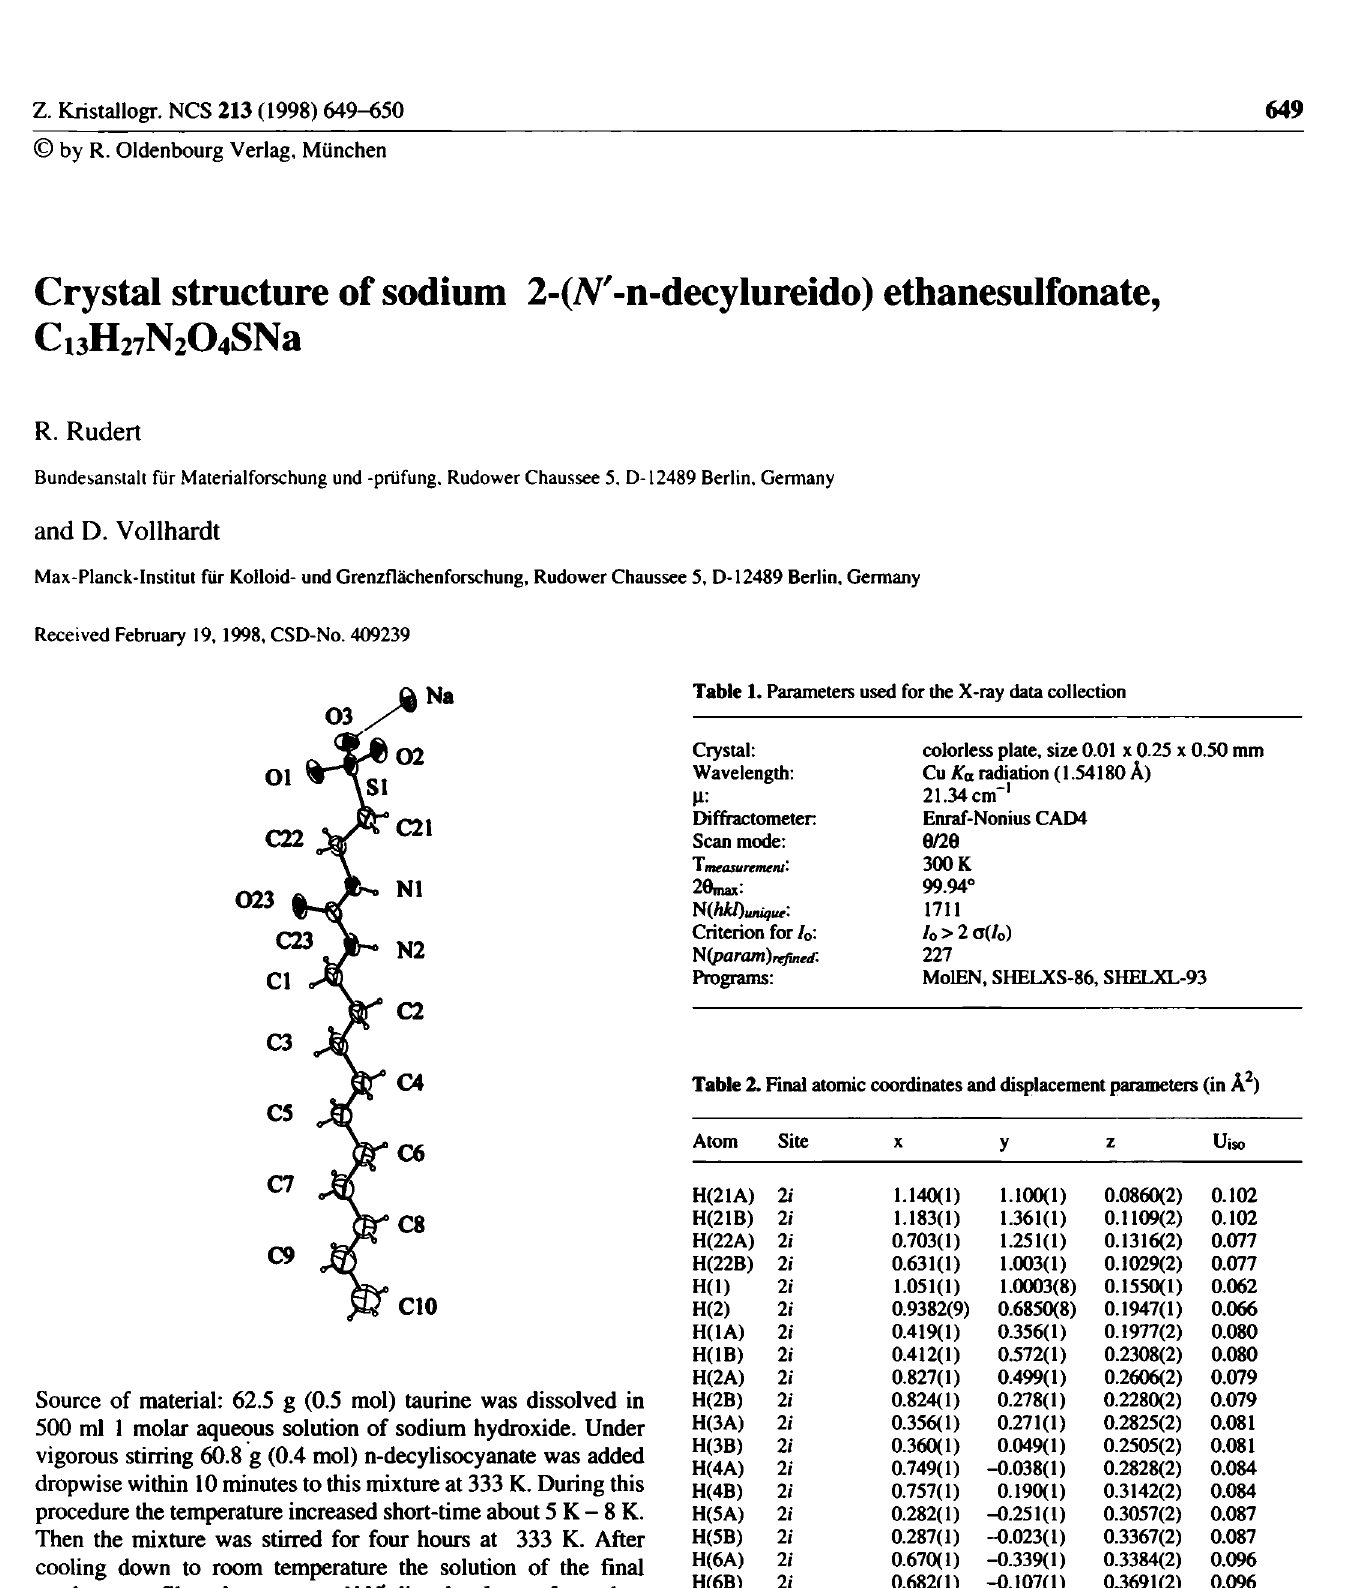
Table 2. Final atomic coordinates and displacement parameters (in